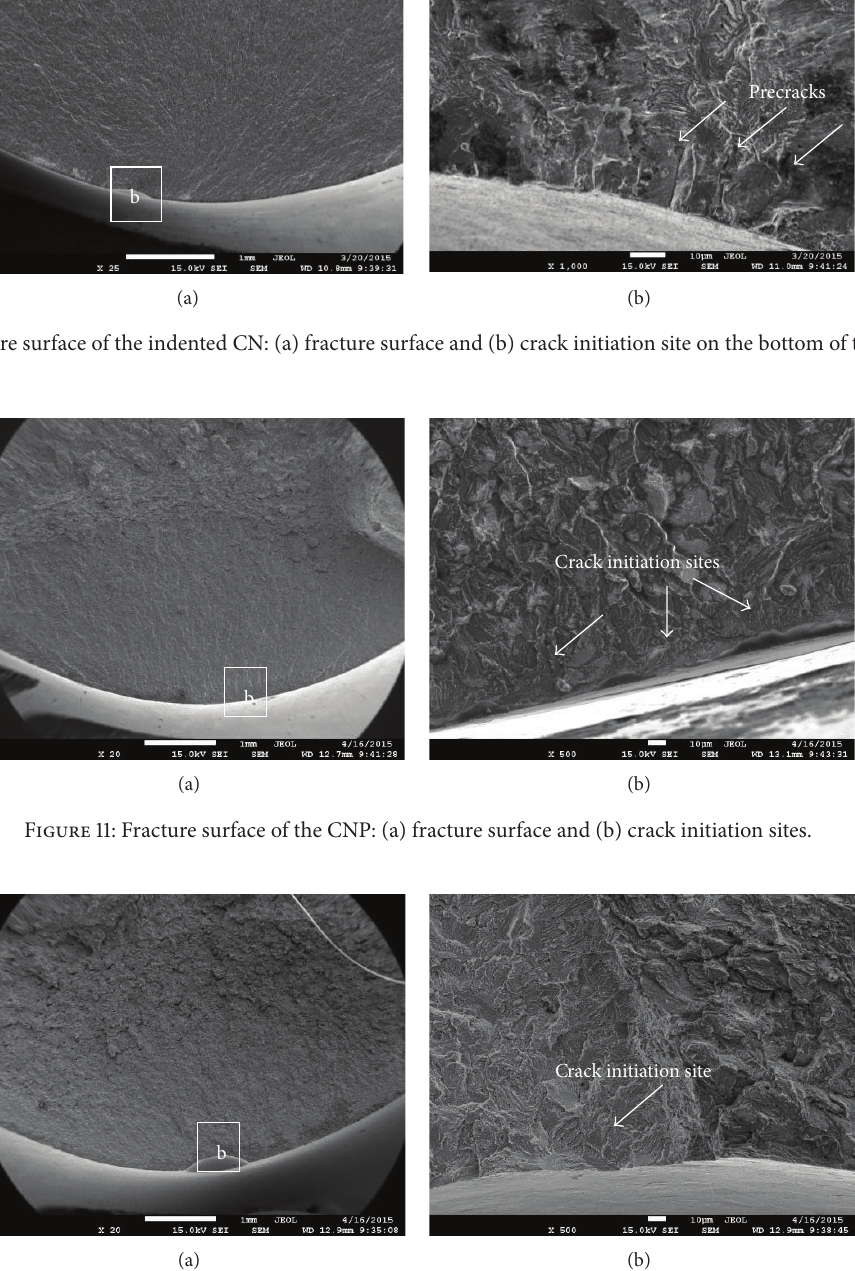
Figure 12: Fracture surface of the indented CNP: (a) fracture surface and (b) crack initiation sites on the bottom of the indentation.